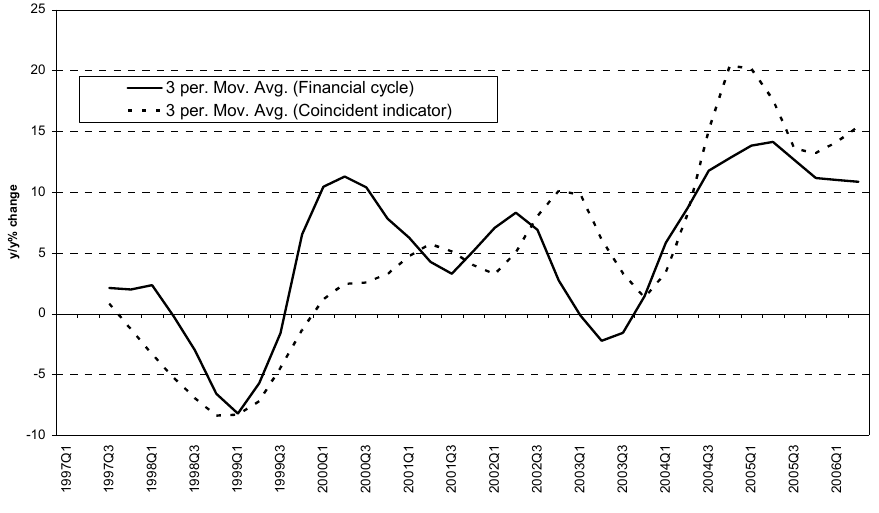
FIGURE 5: Three-period moving average: Coincident indicator vs. the financial indicator